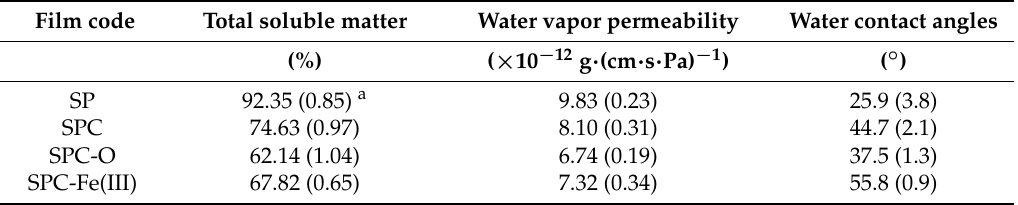
Table 4. Total soluble matter (TSM), water vapor permeability (WVP), and surface hydrophobicity (WCAs) of control and soy-based composite film